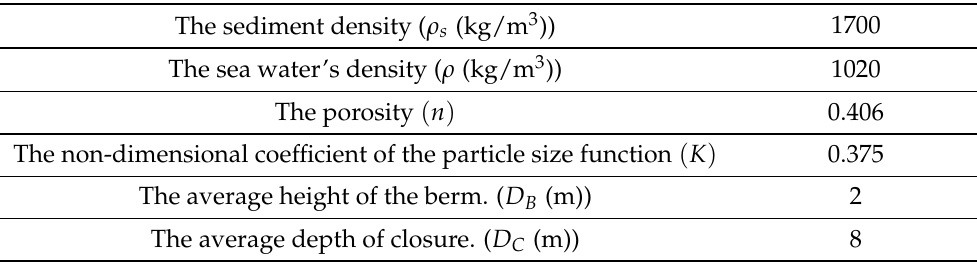
Figure 5. Wave crest impact in one year (360 days). Table 1. Parameters of sand transport rate.